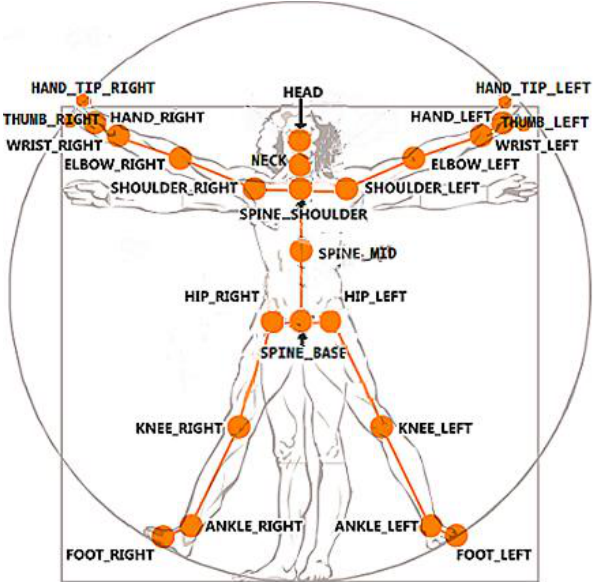
Figure 2. Skeletal model provided by the Software Development Kit (SDK) consisting of the 3D locations of 25 joints [37].